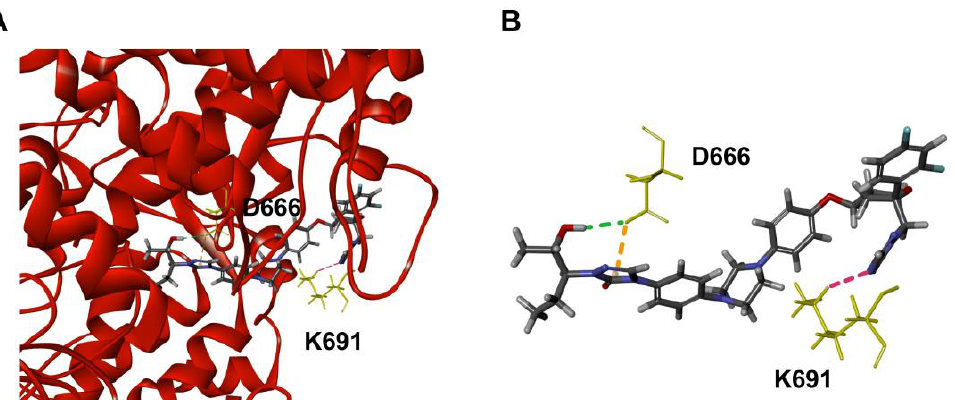
Figure 3. Molecular docking of RdRp and POS. ( A ) The overview of POS bound with the docking pocket of RdRp. The yellow sticks represent the amino acids interacting with POS. The stick model represents POS (light gray, hydrogen atoms; deep gray, carbon atoms; red, oxygen atom; purple, nitrogen atoms; and cyan, fluorine atom). ( B ) The detailed intermolecular bonds between POS and RdRp. Conventional hydrogen bond between D666 and POS is shown in green. Pi – anion interaction is orange. Pink bond represents the carbon hydrogen bond interaction between K691 and POS.